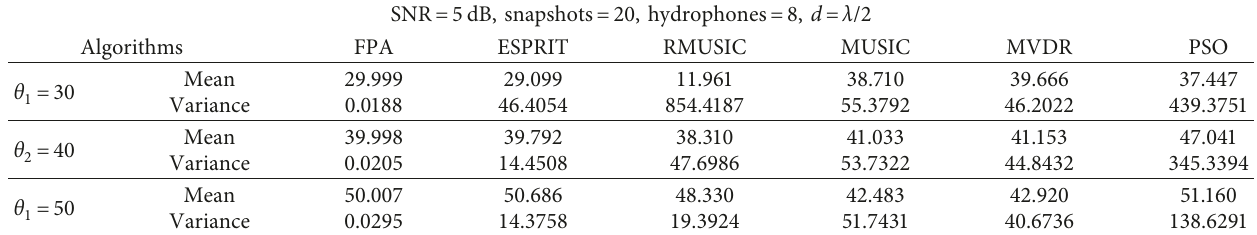
Table 2: Estimation accuracy for three sources.